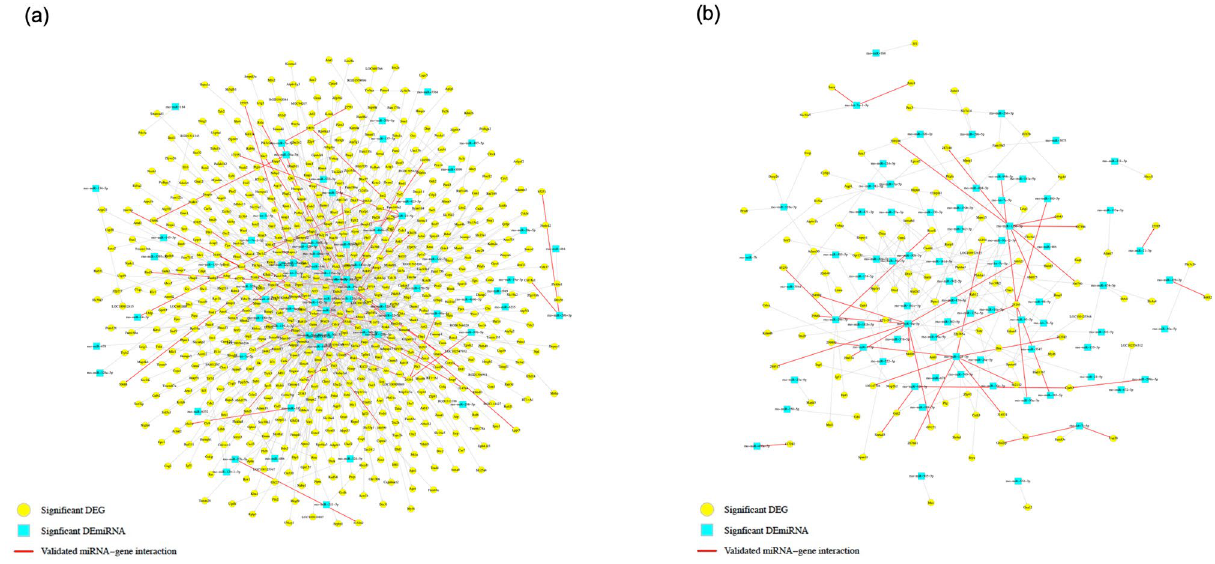
Figure 2. Predicted and validated miRNA-mRNA target network. Using multiMiR, miRNA-mRNA target networks were identified using negative expression correlation following perinatal ( a ) nicotine-alcohol on DA neurons, and ( b ) nicotine-alcohol on non-DA neurons. The node shapes (blue square) denote DEmiRs while (yellow circle) denotes DEGs. Red edges suggest validated miRNA-gene network pairs based on existing evidence from the literature.